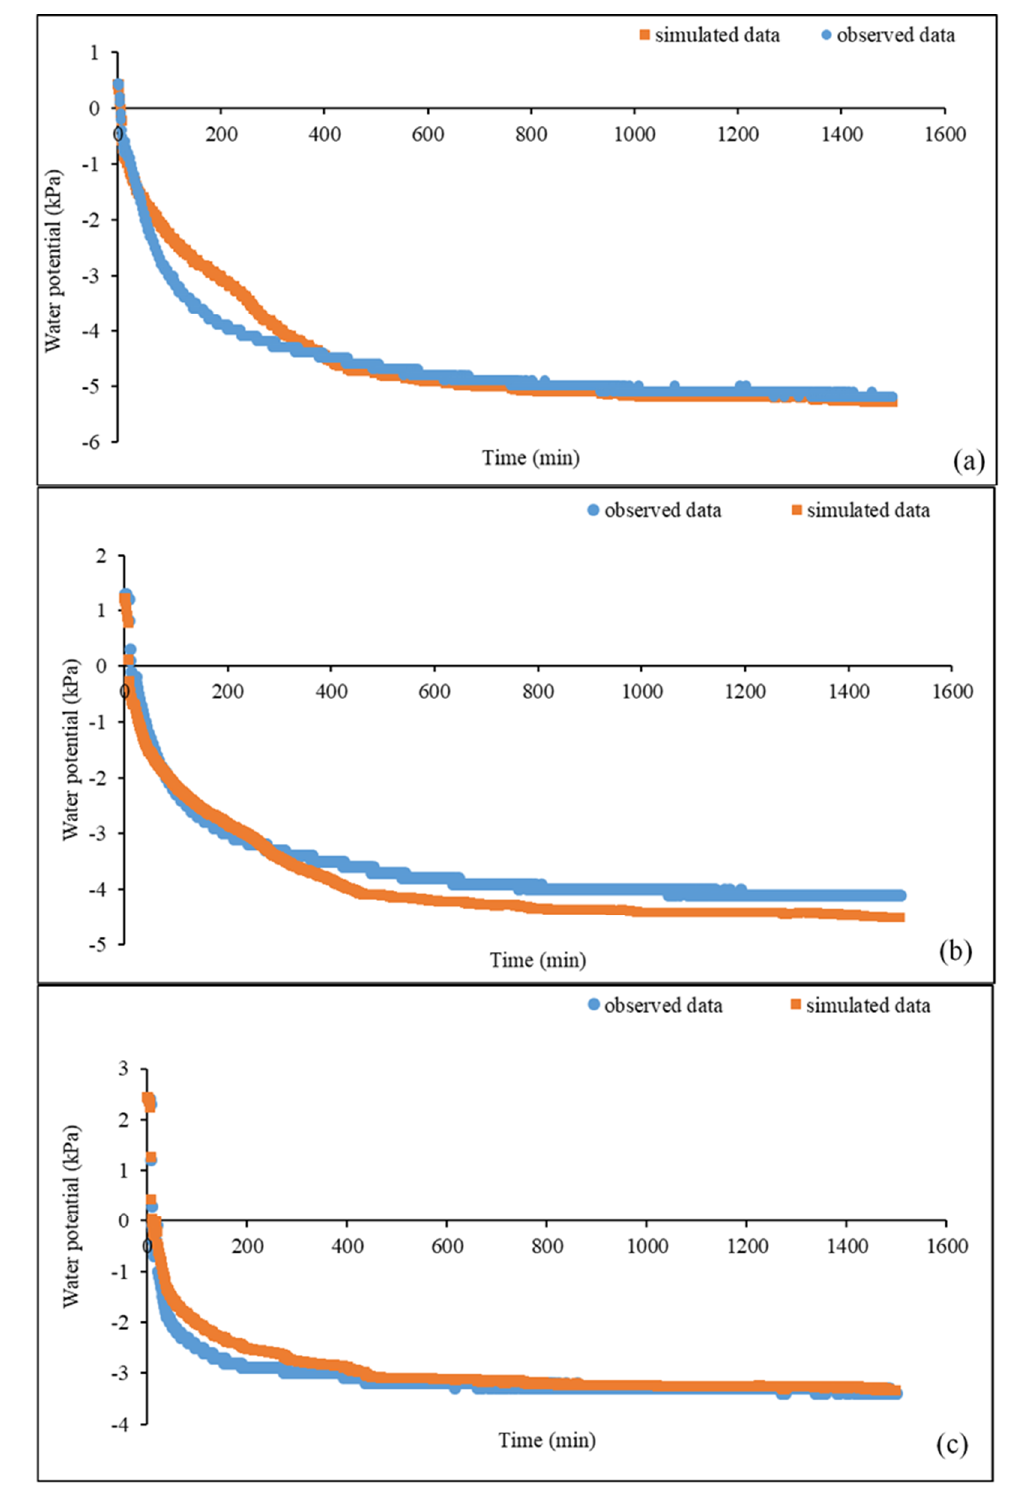
Figure A1. The visual comparison between the observed and simulated water potential values for inverse modelling at the depth of ( a ) 35 mm, ( b ) 120 mm and ( c ) 250 mm.